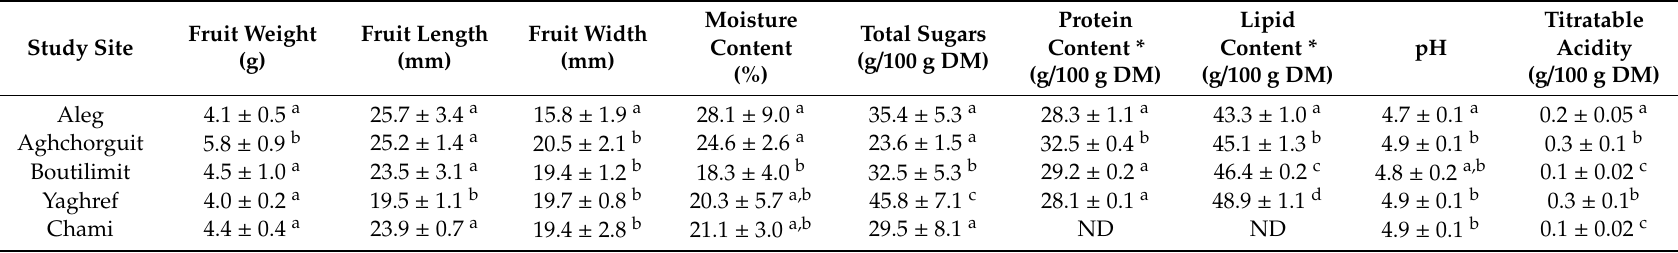
Table 2. Means ± standard deviation of some physicochemical variables measured in fruits of 30 B. aegyptiaca trees from five locations in Mauritania, Northwest Africa.